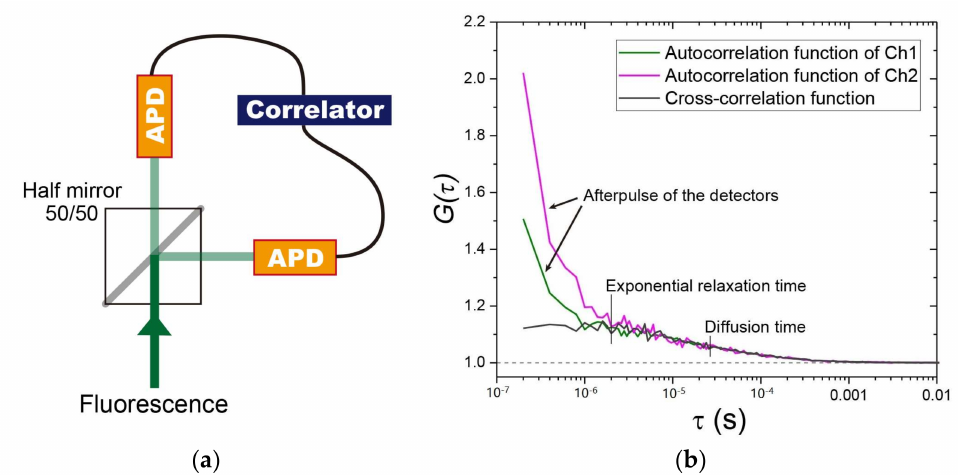
Figure 2. Employing two detectors to reduce autocorrelation curve distortion due to detector afterpulse. ( a ) A fluorescence recoding system using a half-mirror (50/50) and two avalanche photodiodes (APDs). In the system, the denoised autocorrelation function (ACF) is determined based on calculation of the cross-correlation function using the correlator. ( b ) A typical output for an Alexa Fluor 647 dye in Tris-buffered solution. In channels 1 and 2 (green and magenta, respectively), the dominant amplitude of the ACFs within several 10 − 7 s is observed, and is derived from the afterpulse in the detectors. By contrast, the signal derived from the afterpulse can be removed by the cross-correlation function for the two detectors (dark gray). The dashed line indicates the values of